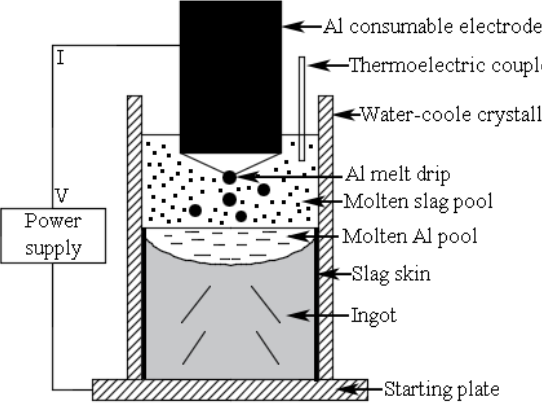
Figure 4: Principle of the electroslag